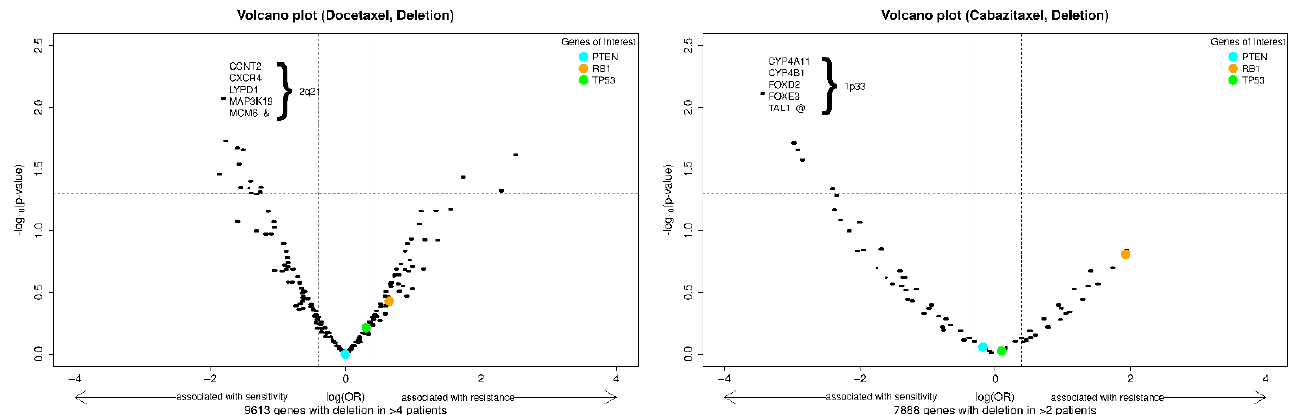
Figure 2. Volcano plots of exploratory biomarkers (amplifications, above; deletions, below) of resistance to docetaxel ( left ) or cabazitaxel ( right ). Note: x -axis = log(OR), y -axis = − log 10 (raw p -value). The vertical dash lines indicate an effect size (OR) of 2 and 0.5; the horizontal dash line indicates a (unadjusted) p -value of 0.05. The p -values are the raw p -value prior to false discovery rate adjustment. Specific genes of interest were indicated with colored dots. Among the genes with the most significant and identical p -values, a selected 5 are shown in each panel. #: 24 genes have most significant and identical p -values; $: 14 genes have most significant and identical p -values; &: 17 genes have most significant and identical p -values; @: 26 genes have most significant and identical p -values (Supplementary Table